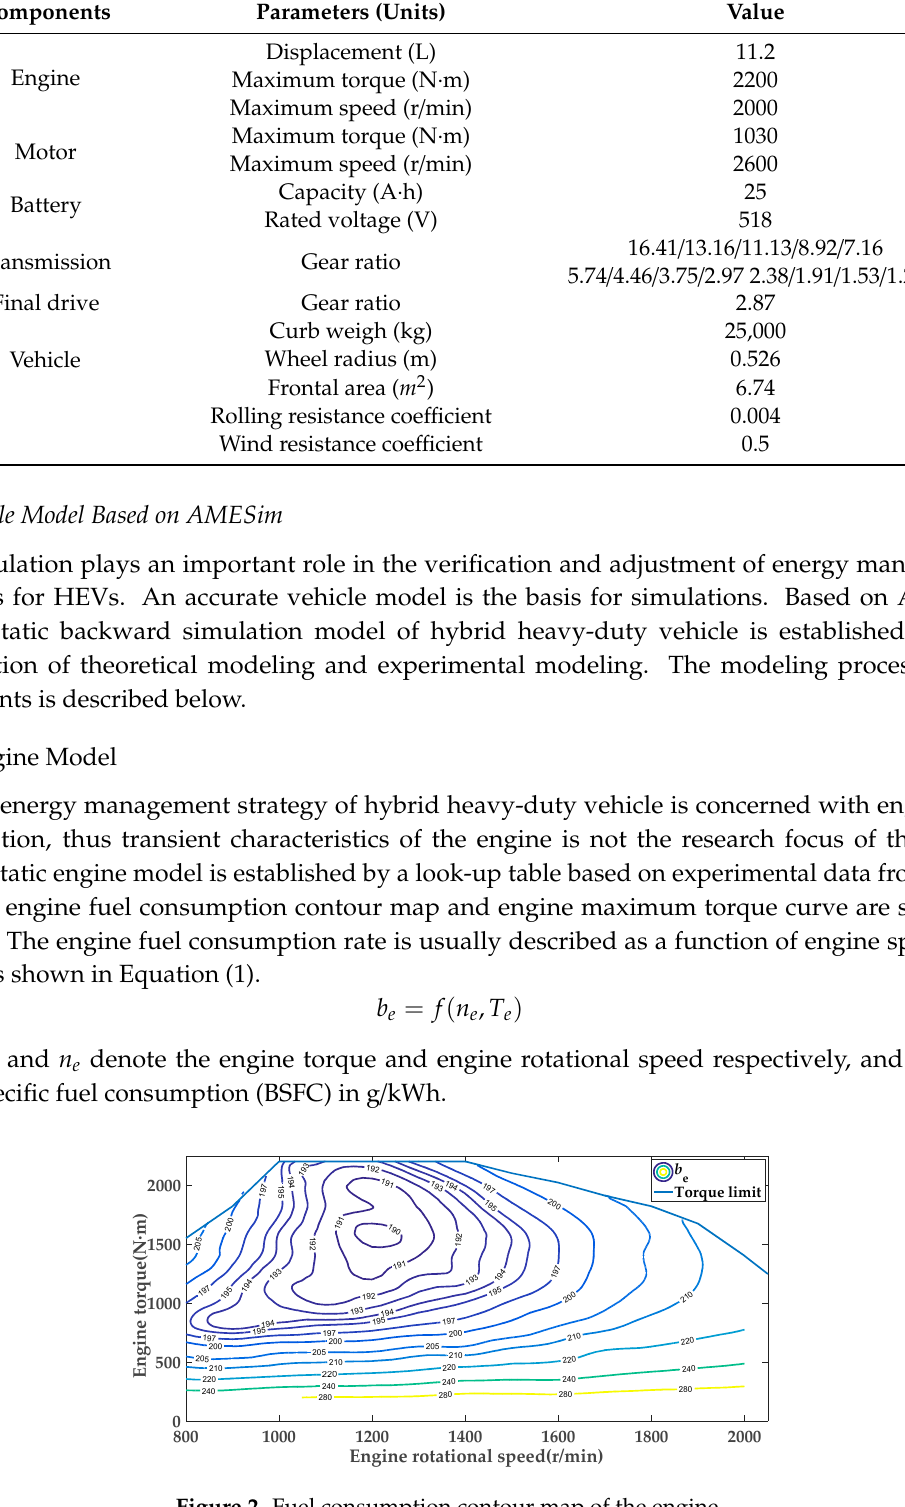
Figure 2. Fuel consumption contour map of the engine.